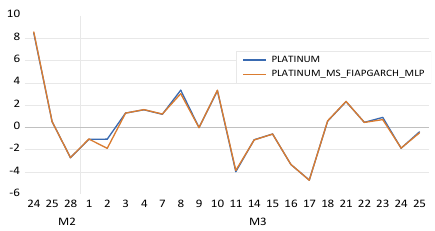
Figure 7. Platinum, MS−FIAPGARCH−MLP.